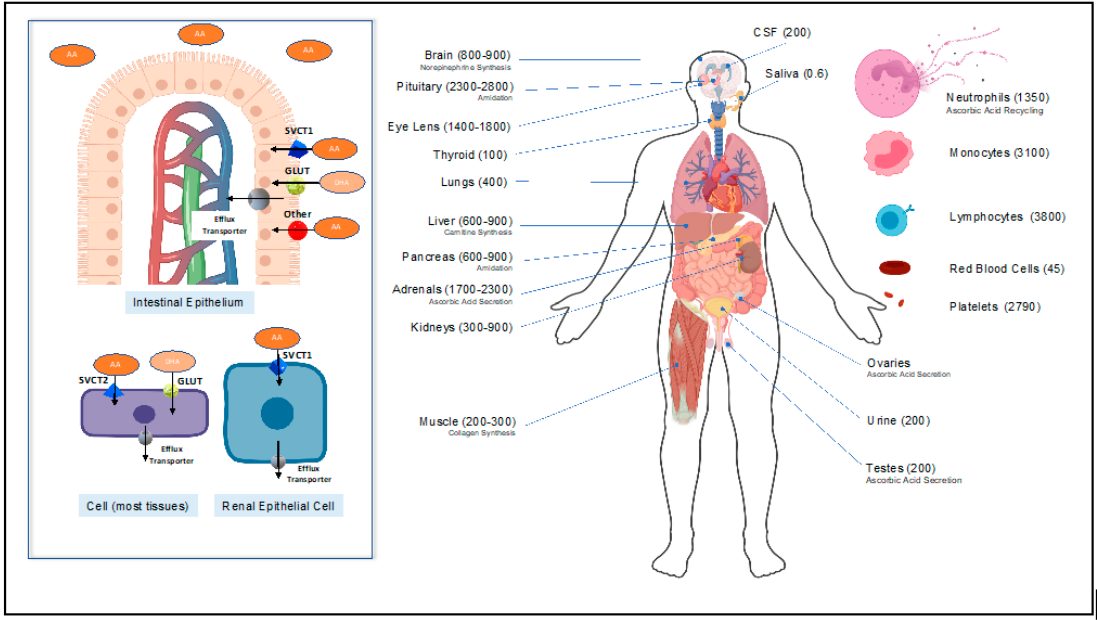
Figure 2. Ascorbic Acid (AA) and dehydroascorbic Acid (DHA) transporters ( left ). Concentration of AA and DHA in human organs and cells in uM ( right ). Inspired by Padayatty and Levine [25].